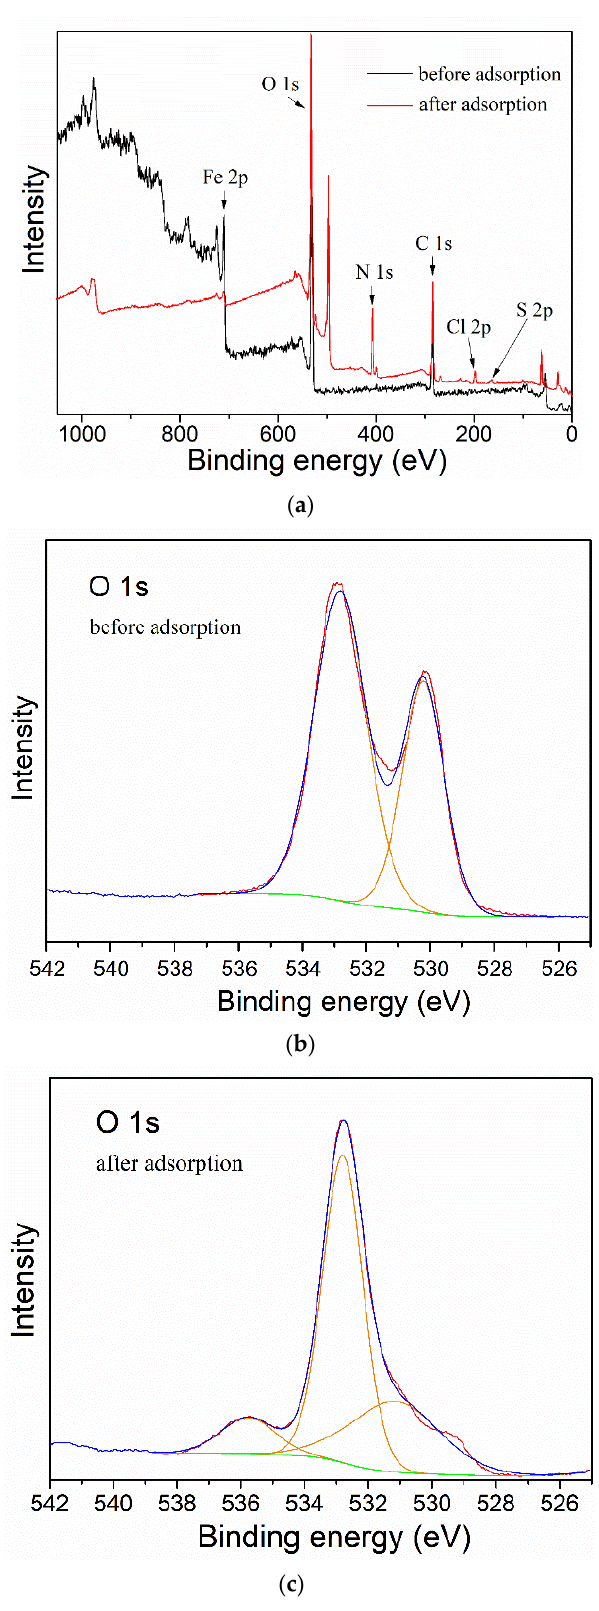
Figure 13. The XPS survey spectra ( a ), curve fitting for O 1s spectra of mag-hydrogel before ( b ) and after ( c ) MB adsorption.